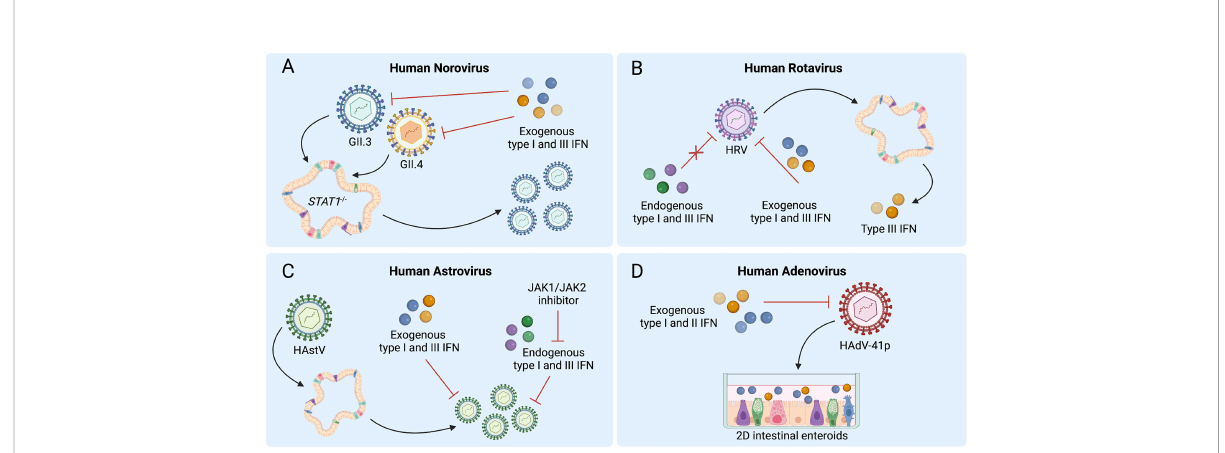
FIGURE 2 Human intestinal enteroids (HIEs) support the discovery of interferon (IFN) responses to enteric viruses. (A) STAT1 -/- HIEs, which lack IFN signaling, demonstrate enhanced norovirus GII.3 replication whereas exogenous type I and III IFN reduce replication of both GII.4 and GII.3 in wild-type HIEs. (B) Human rotavirus (HRV) infection of HIEs induces type III IFNs, while pretreatment of HIEs with exogenous but not endogenous type I and III IFNs can inhibit HRV replication. (C) Treatment with exogenous type I and III IFNs prior to human astrovirus (HAstV) infection reduces viral replication while treatment with ruxolitinib, a JAK1/JAK2 inhibitor, increases HAstV replication. HAstV induces both type I and III IFN responses. (D) Type I or III IFN treatment of HIE monolayers inhibits replication of adenovirus HAdV-41p. Figure created with